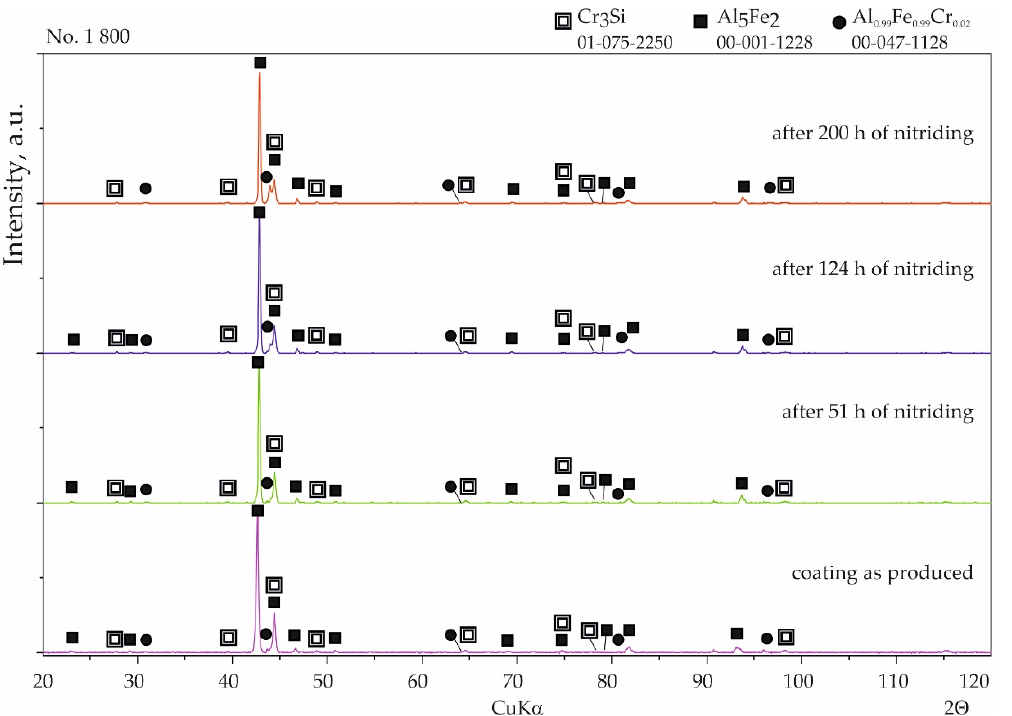
Figure 8. Qualitative X-ray structure analysis (XRD) of the Al–Si coating on 1.4541 steel produced at 800 °C and 2 h; from the bottom: in the initial state; after 51 h of nitriding; after 124 h of nitriding; and after 200 h of nitriding.